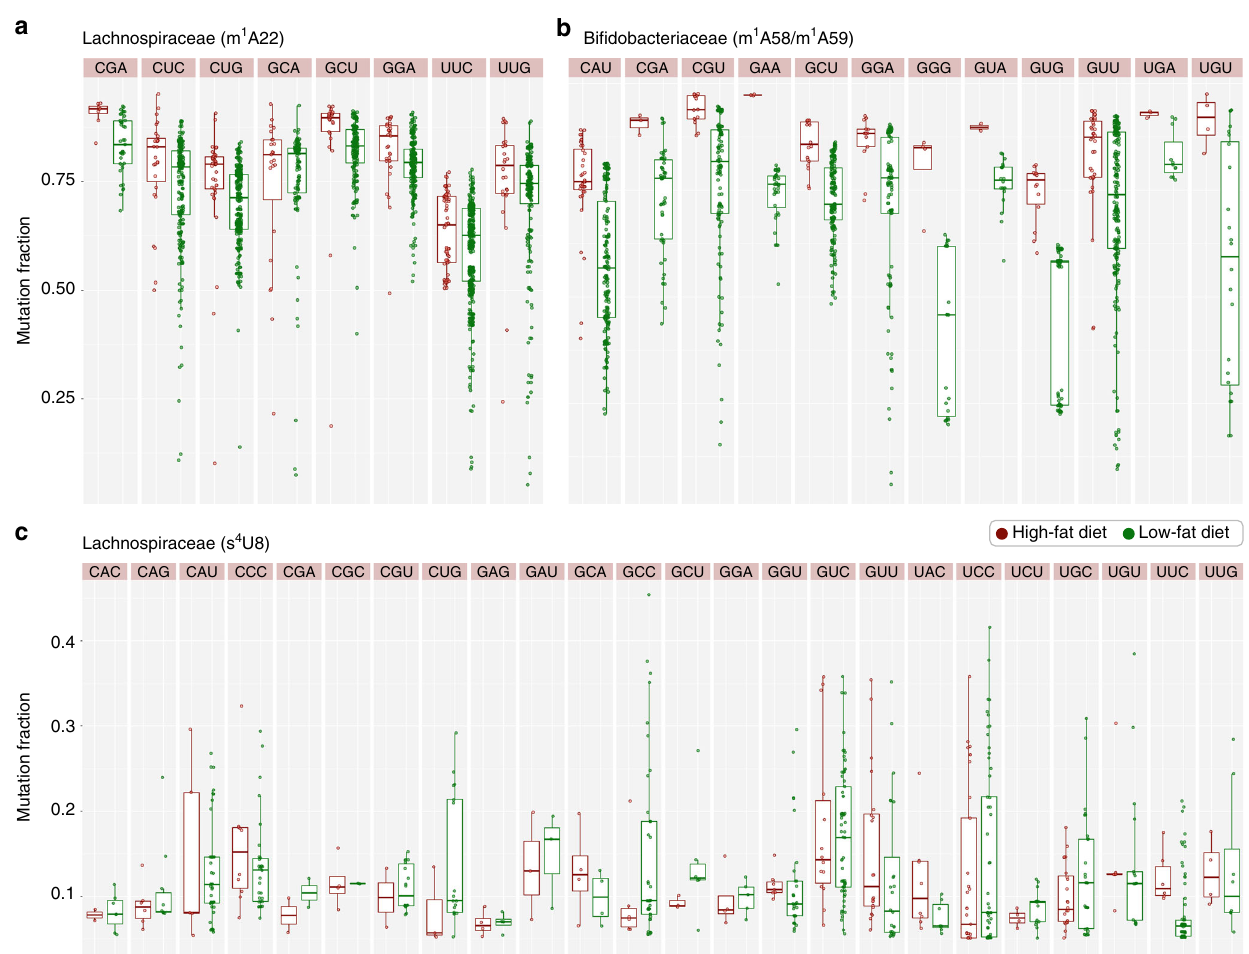
Fig. 6 Comparisons of mutation fractions of HF versus LF samples. Bacterial families with the highest numbers of modi fi cations at the respective nucleotides are shown. Each pair shows HF and LF samples with distinct anticodons marked on top. The amino acid whose codons are read by the corresponding tRNA with designated anticodon can be found in Supplementary Table 4. Box-and-whisker plots show median as a line, upper and lower quartiles in the box, and outliers outside of the line. a m 1 A22 from Lachnospiraceae, class Clostridia. b m 1 A58 and m 1 A59 from Bi fi dobacteriaceae, class Actinobacteria. c s 4 U8 from Lachnospiraceae, class